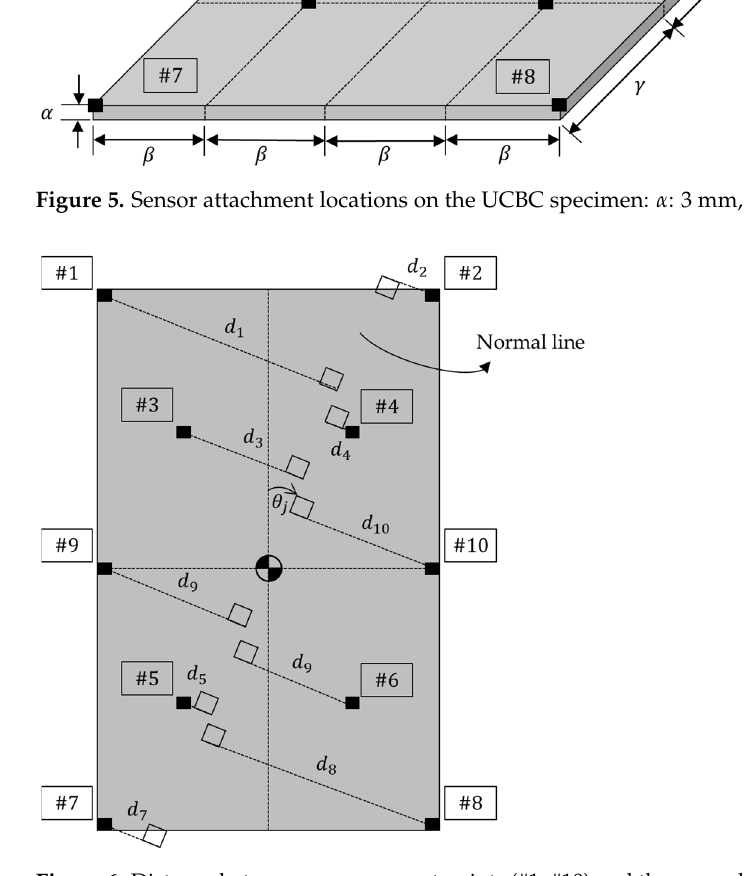
Figure 6. Distance between measurement points (#1–#10) and the normal line for the UCBC specimen with carbon fiber orientation 𝜃 𝑗 .